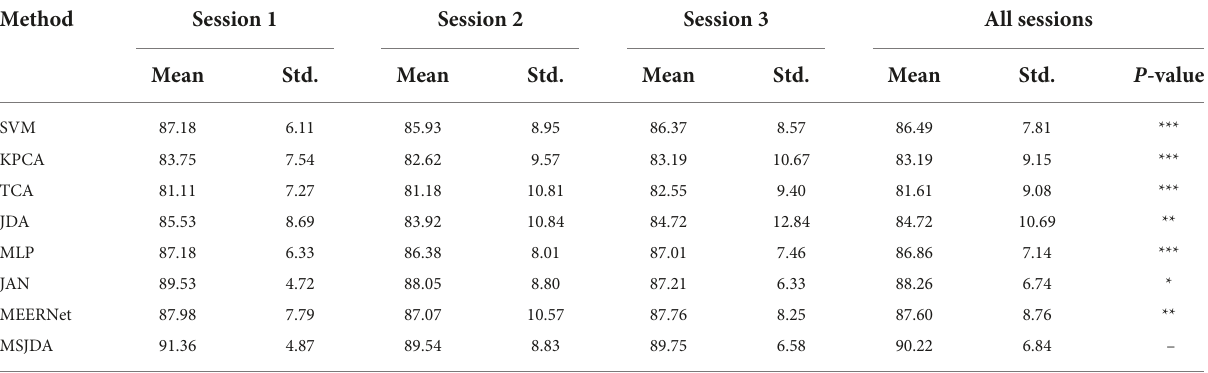
TABLE 2 Average results of cross-session experiments